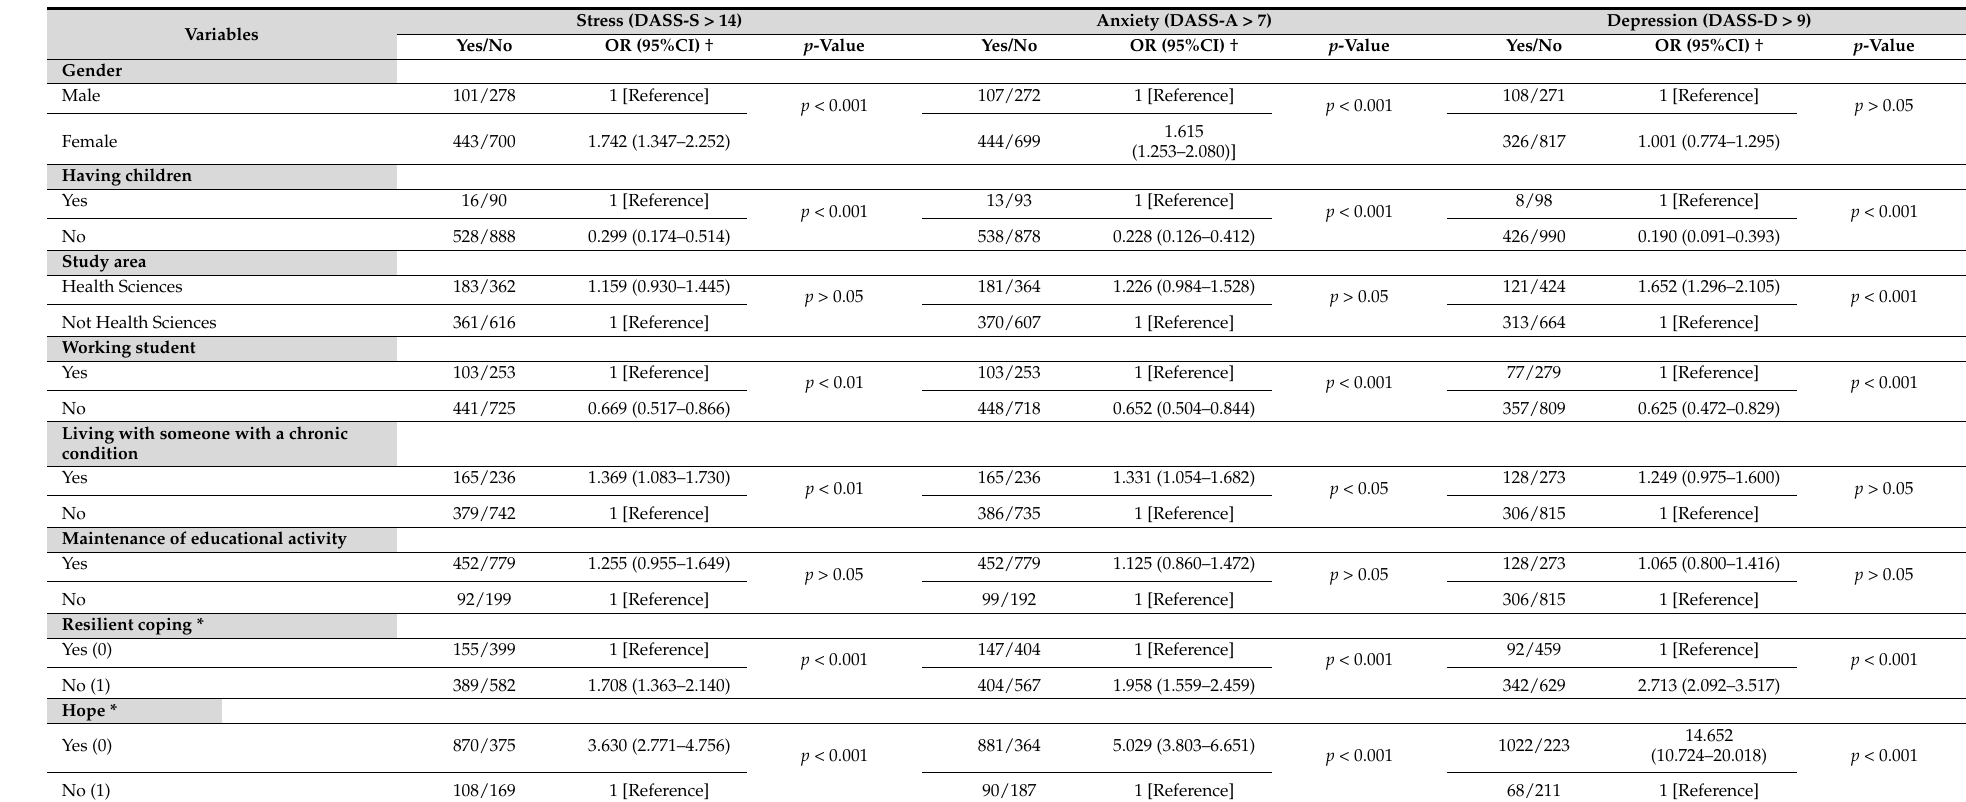
Table 4. Regression analysis of variables by stress, anxiety, and depression among students ( n =